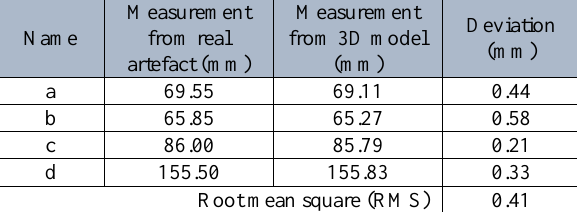
Table 3. Measurement differences between real artefact and 3D model